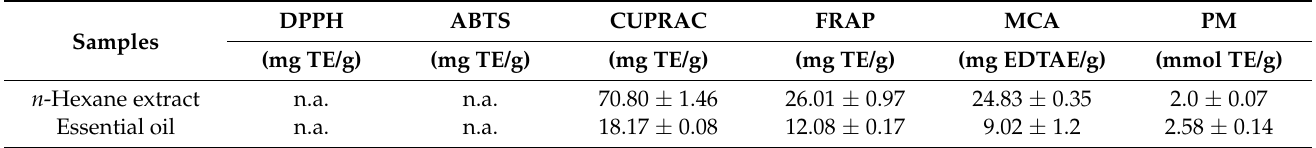
Table 2. Antioxidant potential of the n -hexane extract and essential oil isolated from P. guajava